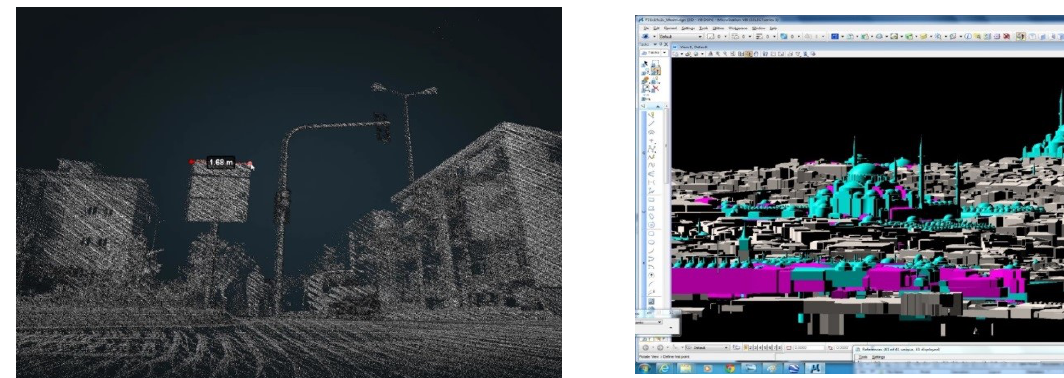
Figure 12: Points cloud of the buildings and other features The above figure (Figure 12) shows the points cloud from mobile mapping system and below shows the points cloud with CAD data (Figure 13 and Figure 14).